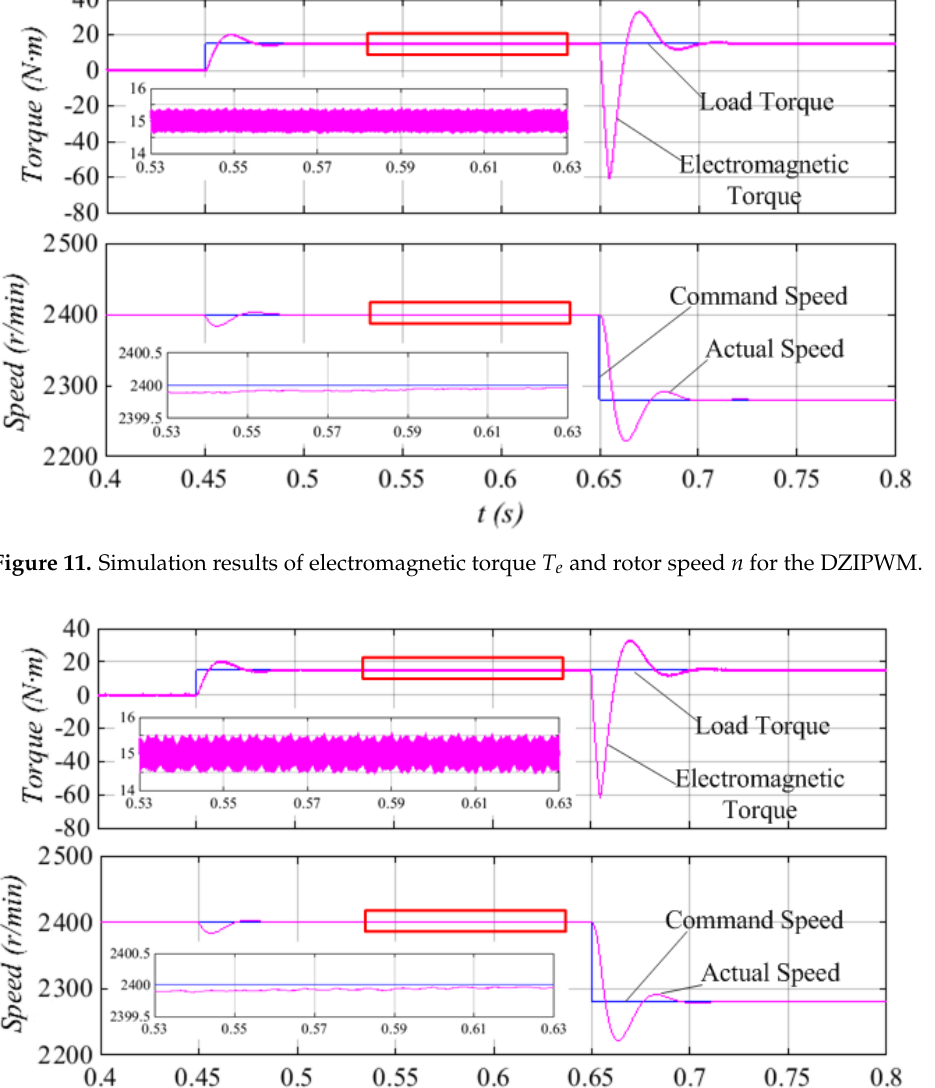
Figure 14. Simulation waveforms of line voltage u ab for DZICMV at m = 0.9703: ( left ) line voltage u ab ( right ) the FFT analysis of u ab . i a i u